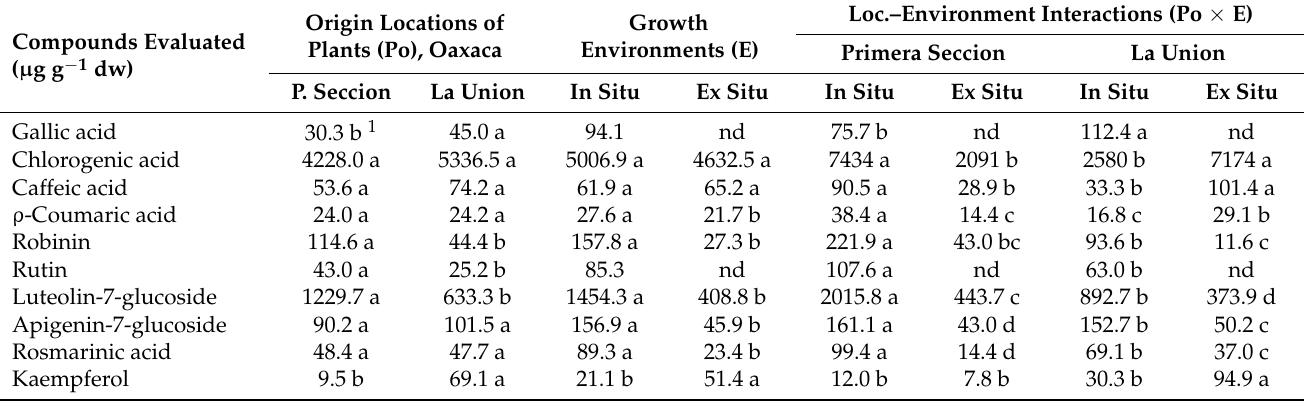
Table 5. Phenolic acid and flavonoid contents in A. petiolaris plants grown under natural (in situ) and cultivated (ex situ) conditions by HPLC-DAD from SM Huamelulpam, Oaxaca,